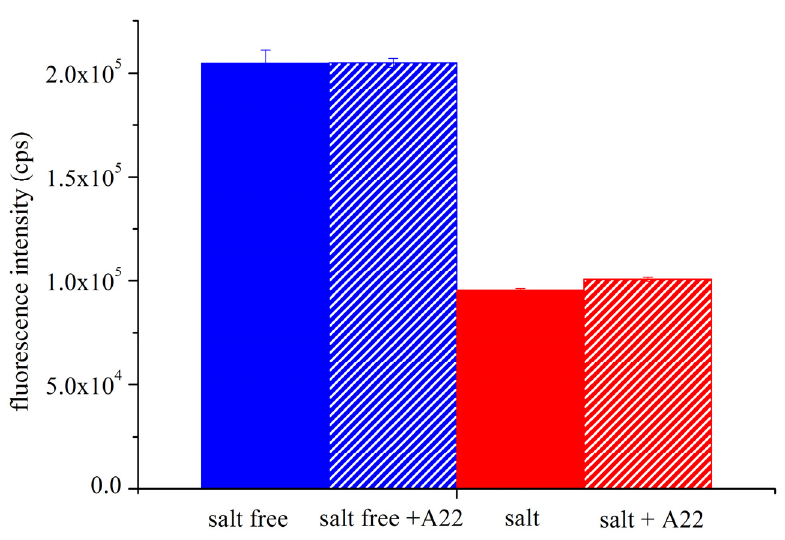
Figure 6. The fluorescent ATP analogue TNP ‐ ATP binds more tightly to Tm ‐ MreB in salt ‐ free environment. We incubated 20 μ M Tm ‐ MreB overnight in a salt ‐ free (blue) or high ‐ salt (red) environment with 1 μ M TNP ‐ ATP, in the absence or presence of 50 μ M A22 (+A22 indicated). The next day, the fluorescence intensity was measured from TNP ‐ ATP.